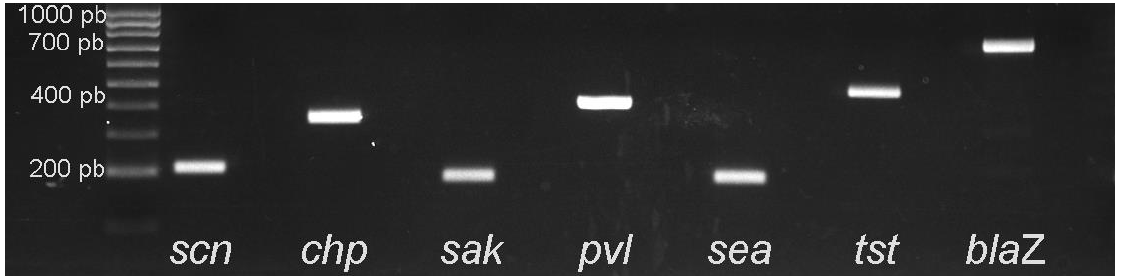
Figure 2. PCR detection of the IEC Cluster (scn, chp, sak and sea), blaZ, tst and the PVL genes among MRSA isolates. The figure shows the positive and negative control of each gene.